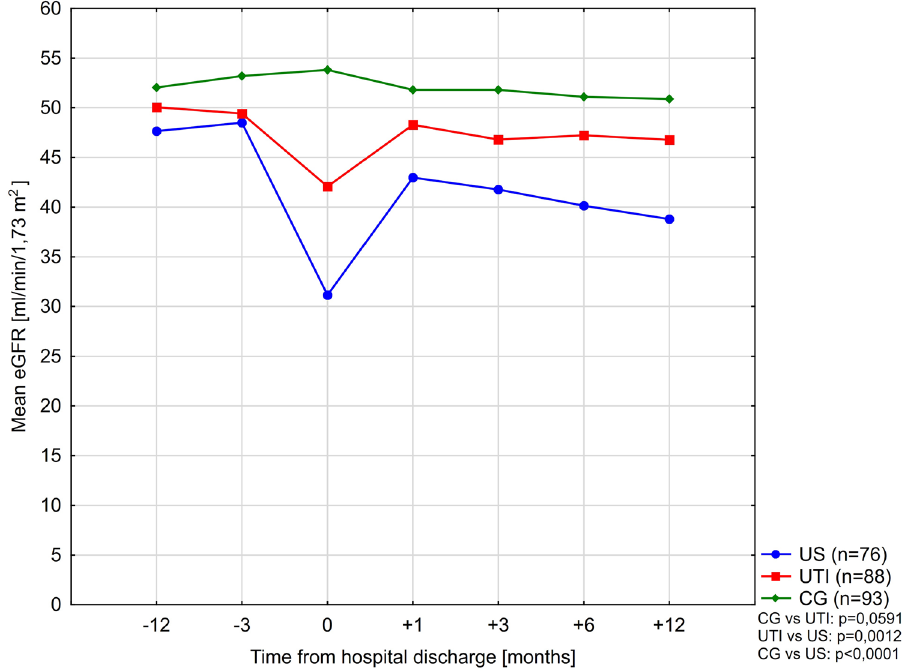
Figure 3. Mean eGFR values in the study groups during the observation period. Patients with graft loss registered at any point of the study were not included on the graph.